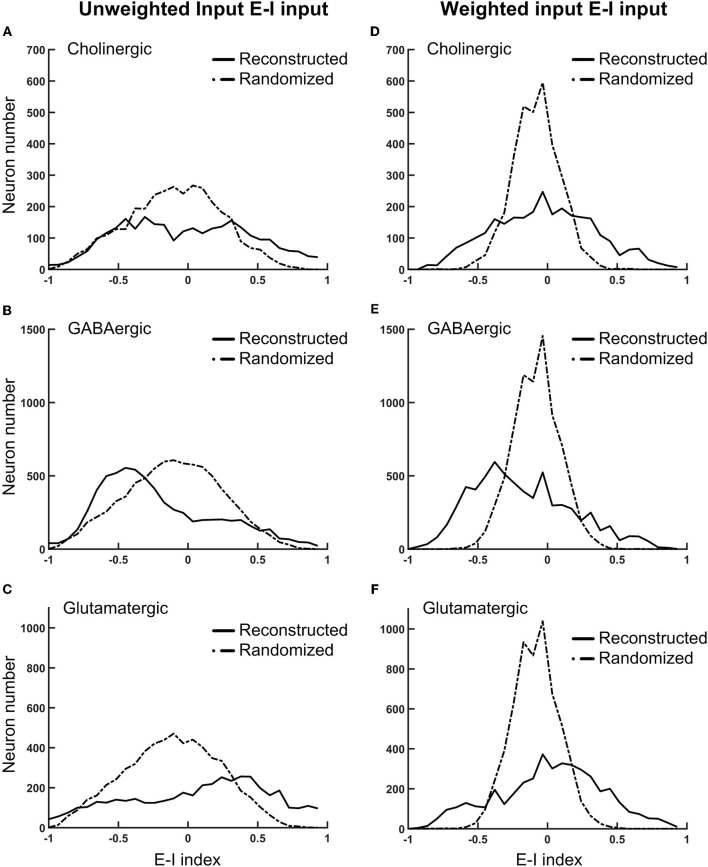
The normalized difference between the excitatory and inhibitory inputs (the E-I index) for different types of neurons in the fruit fly brain indicates the striking diversity of the local circuits (A–C) The distributions of the E-I index of each neuron, plotted separately for the putative cholinergic, GABAergic, and glutamatergic neurons, respectively. (D–F) Same with the panels (A–C), respectively, but the E-I index are calculated based on the connections weighted by the contact point numbers. Solid curves: the reconstructed fruit fly brain. Dashed curves: the randomized fruit fly brain. The reconstructed brain exhibits much broader distributions than the randomized brain does in all conditions. The putative GABAergic neurons receive more inhibitory inputs, while the putative glutamatergic neurons receive more excitatory inputs in the reconstructed than in the randomized brain.